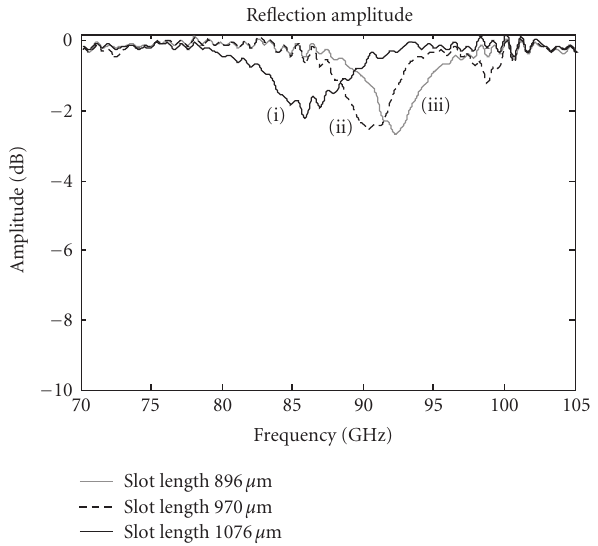
Figure 2: Measured reflection amplitudes of di ff erent slot length grounded FSSs. (Slot length of curve (i) 1076 μ m, curve (ii) 970 μ m, and curve (iii) 896 μ m.)